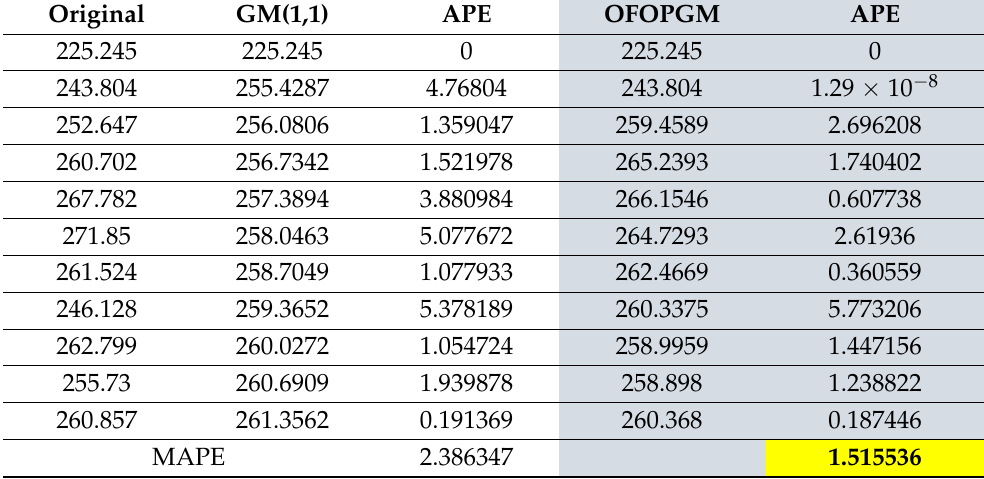
Table 2. Co 2 emission forecast 2